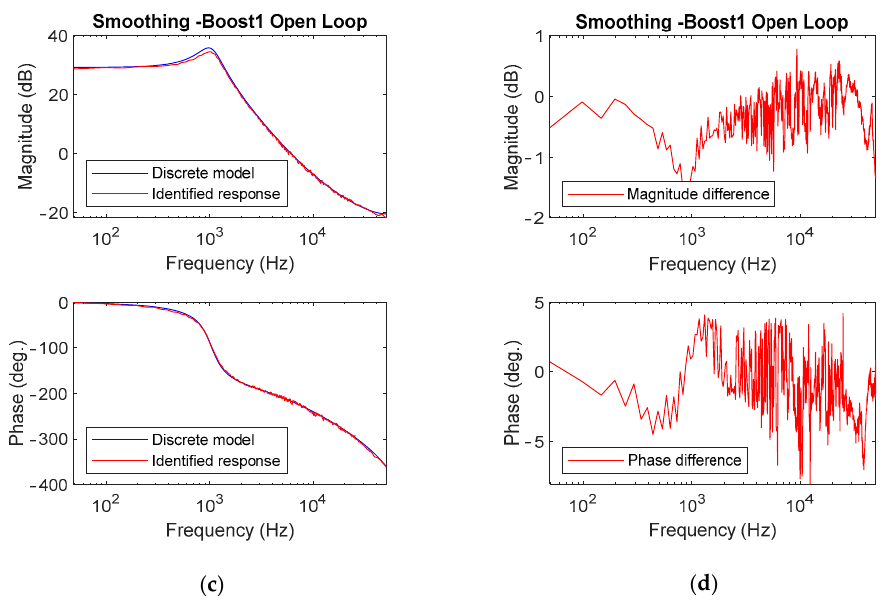
Figure 12. Boost converter open-loop results. ( a ) Bode plot without smoothing process. ( b ) Difference between discrete theoretical model and experimental measurements without smoothing process. ( c ) Bode plot with smoothing process. ( d ) Difference between model and measurement with the smoothing process.